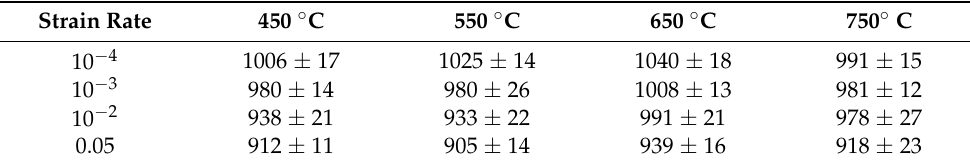
Table 2. The tensile strength of the tested steel at different strain rates (MPa).